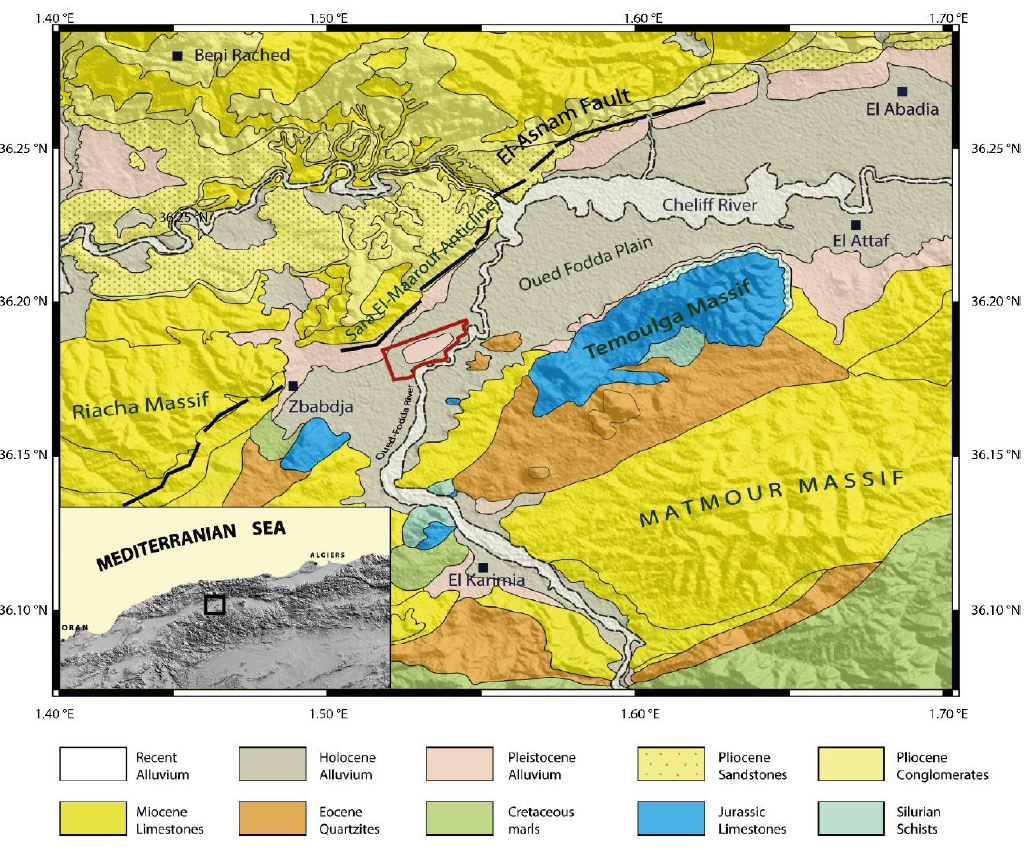
Figure 2. Geological map of Oued-Fodda. Red line is the limit of the city. Thick black lines are the surface traces of the El-Asnam Fault (modified from [26]).